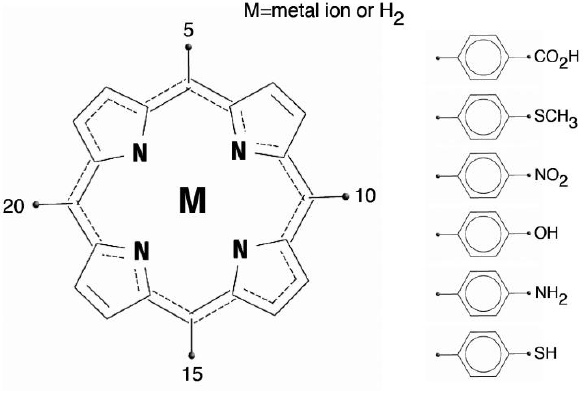
Figure 1. Structure of the porphyrin ring and a set of common substituents in the meso positions (5, 10, 15, 20). The central core of the porphyrin can be occupied by two hydrogen atoms (free base porphyrin) or, as in the figure, by a metal ion (metalloporphyrin).